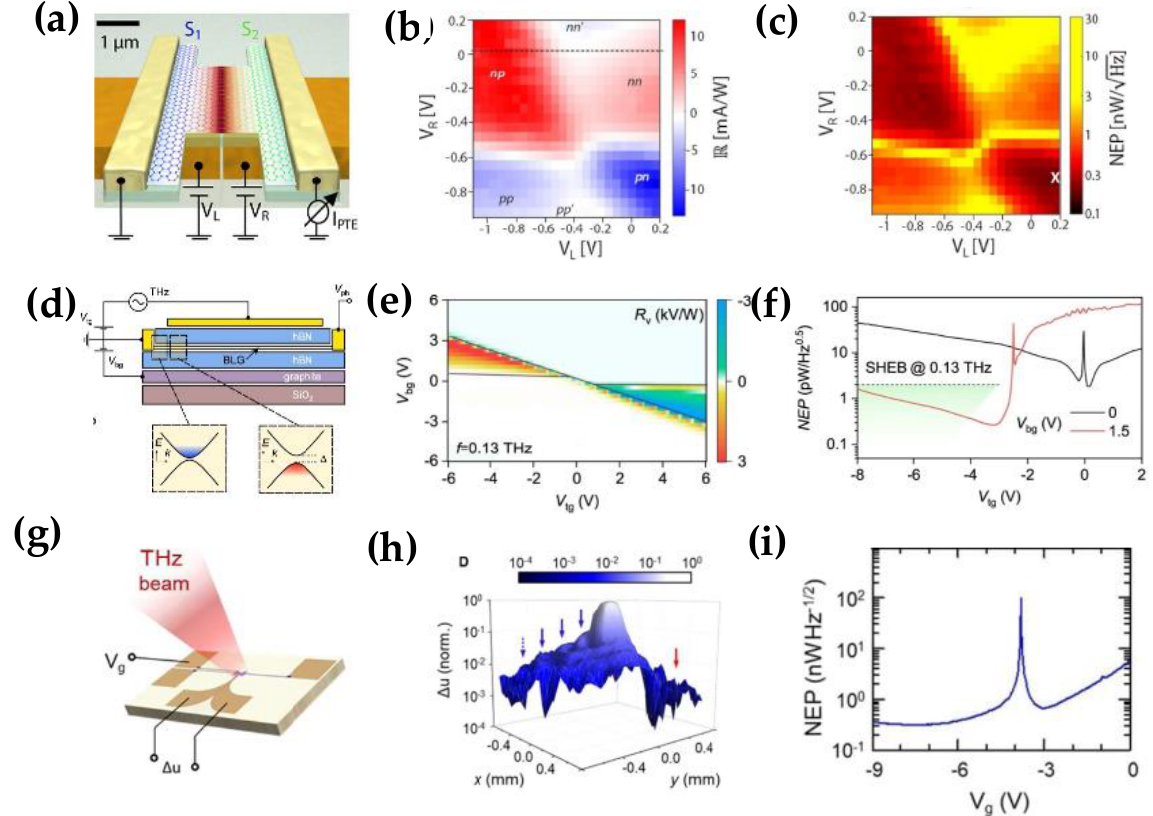
Figure 7. ( a ) Schematic diagram of the antenna − integrated pn junction device; ( b ) Relation between the photo response and the applied voltage of the two branches of the antenna(VL and VR) when the incident frequency is 2.52 THz; ( c ) Noise-equivalent power (NEP); (Reprinted with permission from ref. [104] Copyright 2019, American Chemical Society) ( d ) Schematic diagram of dual-gated BLG transistor in hBN package; ( e ) Relationship between photo response and gated voltage (V bg and V tg ) when the incident frequency is 0.13 THz; ( f ) Noise − equivalent power (NEP) at given V bg ; (Reprinted with permission from ref. [105]. Copyright 2021, Nature Publishing Group) ( g ) Schematic diagram of antenna coupled GEFT; ( h ) Photo response represented by ∆ u; ( i ) Noise − equivalent power (NEP) calculated as a function of V g . (Reprinted with permission from ref. [106]. Copyright 2021, Nanophotonics)